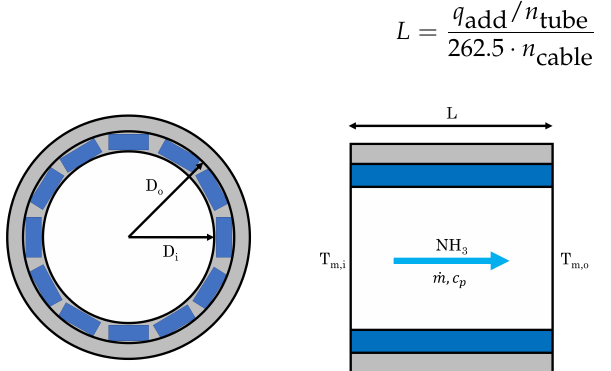
Figure 10. The cross-sections of one fuel heating tube. The head-on view ( left ) shows a notional arrangement of heat tracing cables around the outer surface of the tube. The side-view ( right ) shows the mean inlet and outlet temperatures. Heat trace cables are denoted in blue, insulation in grey, and the fuel in white. Not to